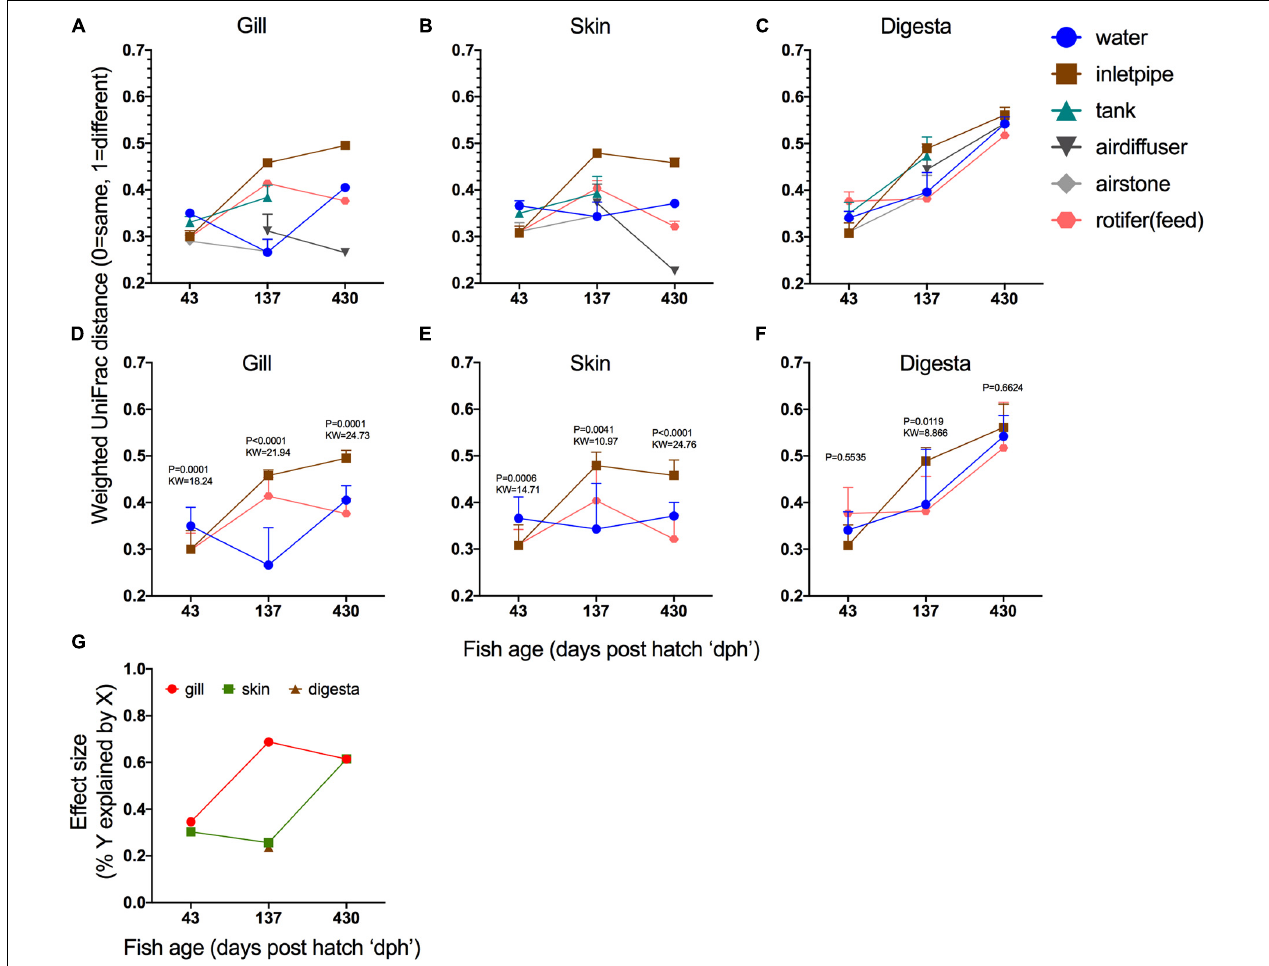
FIGURE 4 | Niche differentiation within body sites over time. Beta diversity distances (Weighted normalized UniFrac) of (A) gill, (B) skin, and (C) digesta samples compared to six different hatchery built environment putative microbial sources [water, inlet pipe, tank side, air diffuser, airstone, and first feed (rotifers)]. Statistical comparison of microbiome differentiation across three BE comparisons (water, inlet pipe, and first feed) over time and calculated independently across three body sites: (D) gill, (E) skin, and (F) digesta (Statistical test: Kruskal–Wallis, P value and KW test statistic reported in figure panel. (G) Results from the Kruskal–Wallis test for (d,e,f) depicted as effect size to demonstrate the rate of microbial community niche